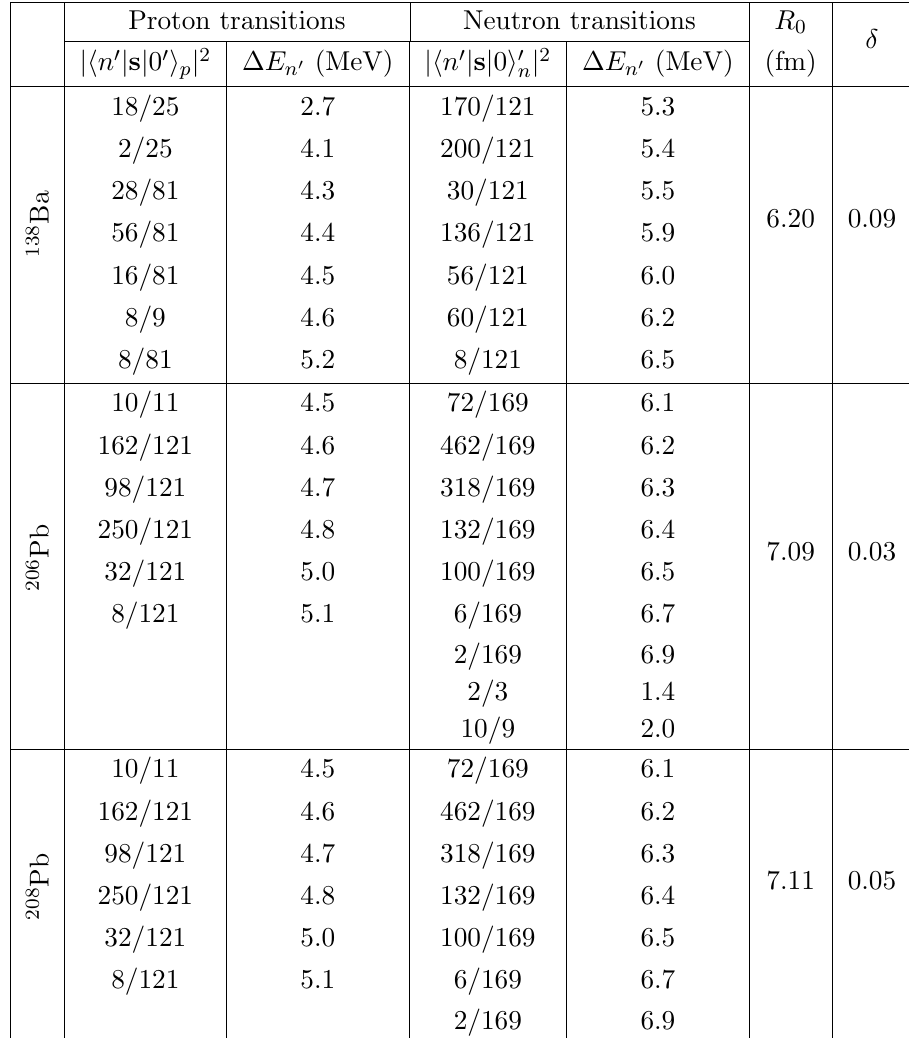
Table 3 . Nuclear radii R 0 , deformation parameters (cid:14) , matrix elements jh n 0 j s j 0 0 i p;n j 2 and the corresponding energies (cid:1) E n 0 of M1 spin-(cid:13)ip transitions in some spherical nuclei of interest.